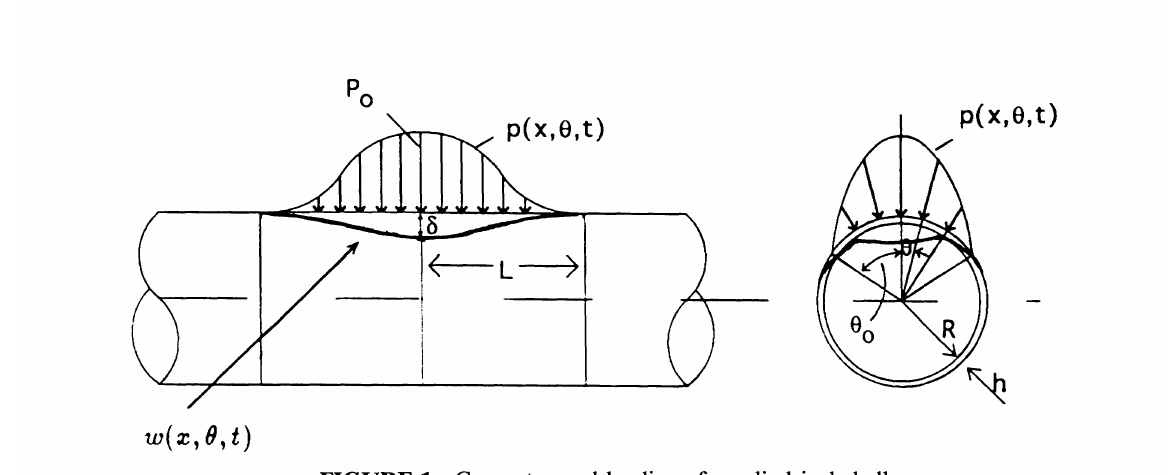
FIGURE 1 Geometry and loading of a cylindrical